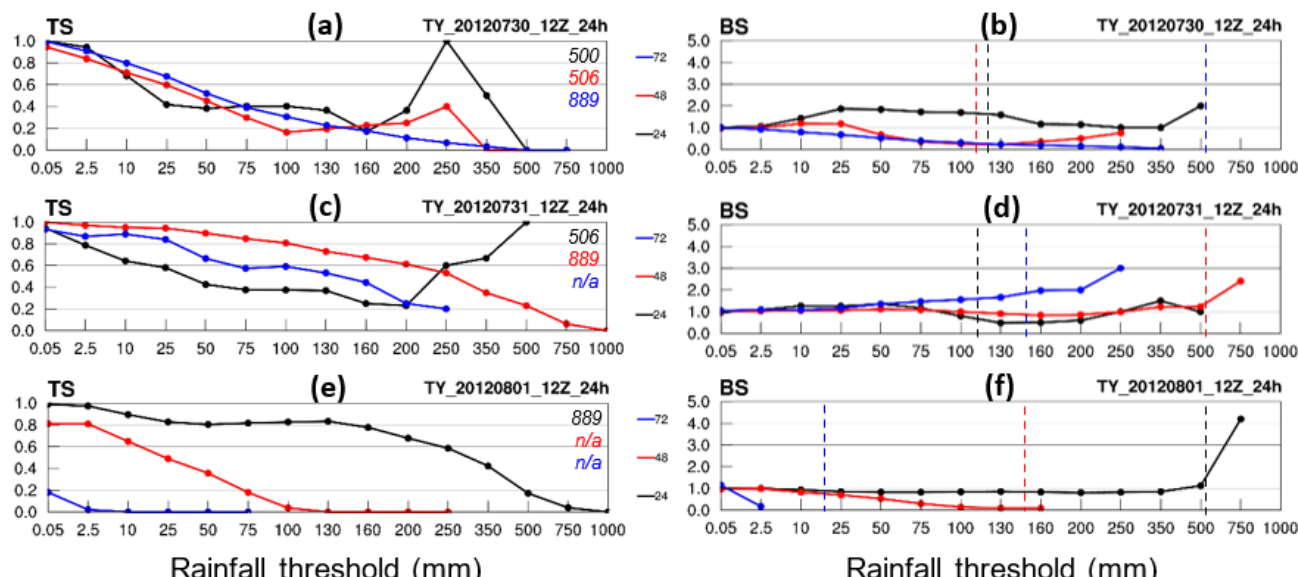
Figure 5. ( a ) TS and ( b ) BS of CReSS 24 h QPFs for day 1 (black), day 2 (red), and day 3 (blue) from the forecast made at 1200 UTC 30 July 2012 during TY Saola (2012) as a function of threshold (mm). ( c – f ) As in ( a , b ), except from the forecasts made at ( c , d ) 1200 UTC 31 July and ( e , f ) 1200 UTC 1 August, respectively. On days 1–3, the observed maximum 24 h rainfall values (mm, rounded to integer) are given at the upper-right corner of TS plots, and the observed base rate ( O / N ) at 10% are also marked (vertical dashed lines) in BS plots using the corresponding color.